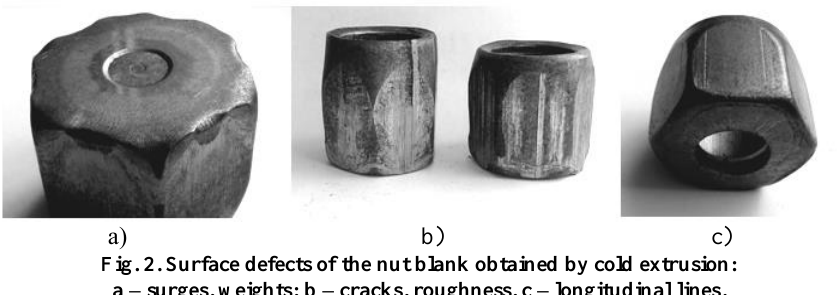
Fig. 2. Surface defects of the nut blank obtained by cold extrusion: